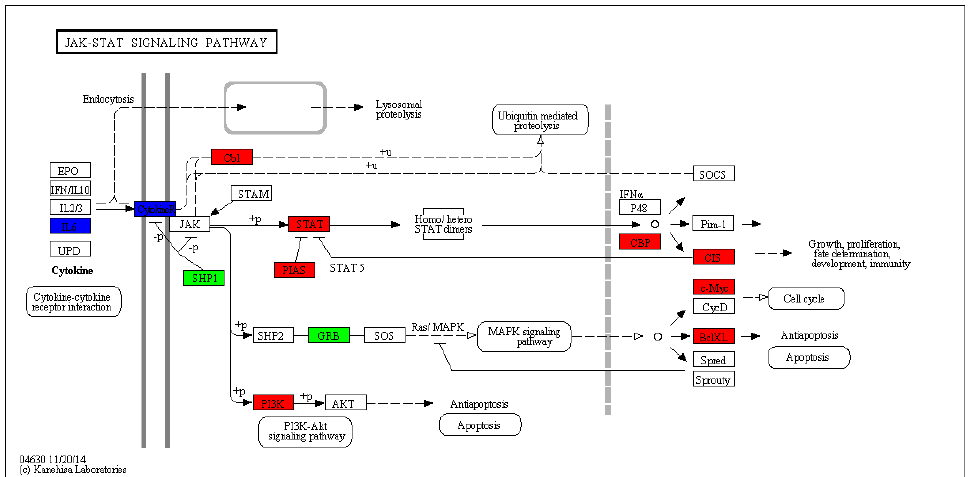
Figure 11. Significantly differentially expressed genes identified by KEGG that are involved in the Jak-STAT signaling pathway. Red boxes indicate upregulated DEGs; Green boxes represented downregulated DEGs; Blue boxes show no changes in expression. (For interpretation of colors used in this figure, please refer to the web version of this article).